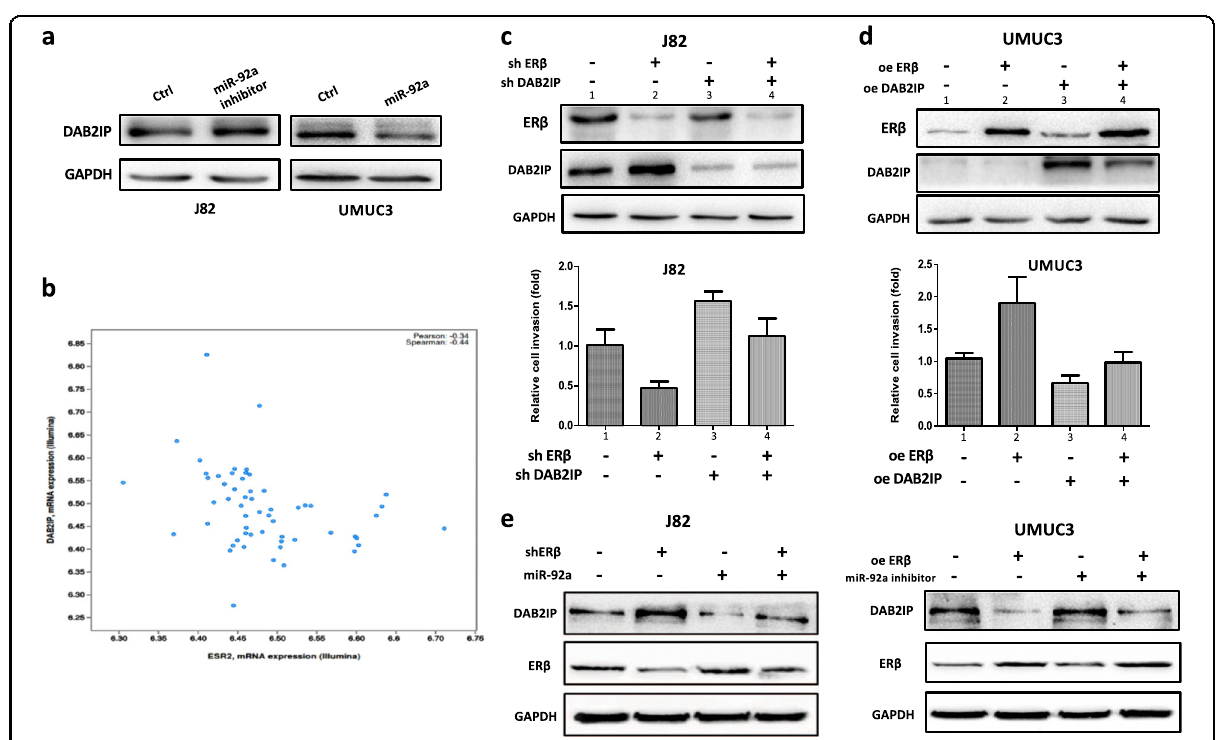
Fig. 3 ER β could up-regulate oncogenic miR-92a to down-regulate the tumor suppressor DAB2IP to promote the BCa cell invasion. a Western blot data showed DAP2IP protein expression is reversely regulated by miR-92a in J82 and UMUC3 cells with or without the miR-92a inhibitor or miR-92a, respectively. b Using cBioPortal databases to analyze the BCa tissues, results showed that DAB2IP and ER β (ESR2) expression are inversely correlated. c Western blot (upper panel) and the transwell invasion assays (lower panel) after modulation of ER β and DAB2IP using lentiviral transduction methods in J82 cells. Results showed shER β (knockdown of ER β ) could up-regulate DAB2IP protein and inhibit cell invasion (lanes 2 vs 1). The addition of lentiviral shDAB2IP can reverse the shER β -reduced J82 cell invasion (lanes 4 vs 2). d Western blot (upper panel) and the transwell invasion assays (lower panel) after modulation of ER β and DAB2IP in UMUC3 cells. Over-expression of ER β (oe ER β ) can down-regulate the DAB2IP protein expression and promote the UMUC3 invasion (lanes 2 vs 1). The ectopic DAP2IP over-expression (oeDAP2IP) can reverse the oeER β up- regulated UMUC cell invasion (lanes 4 vs 3). As the oeDAP2IP can signi fi cantly increase the protein expression, the changes of endogenous DAP2IP protein bands in lanes 1 and 2 were barely observed. The oeER β -down-regulated DAP2IP can be better observed in Fig. 3 e , right panel. e Western blot analysis was used to assay ER β and DAB2IP protein expressions in J82 (left panel) and UMUC3 (right panel) cells after modulation of the ER β expressions (shER β or oeER β ) with or without lentiviral miR-92a or miR-92a inhibitor. In c and d , quanti fi cations of cell numbers that passed through the transwells were averaged from 5 representative fi elds. Data were presented as relative changes